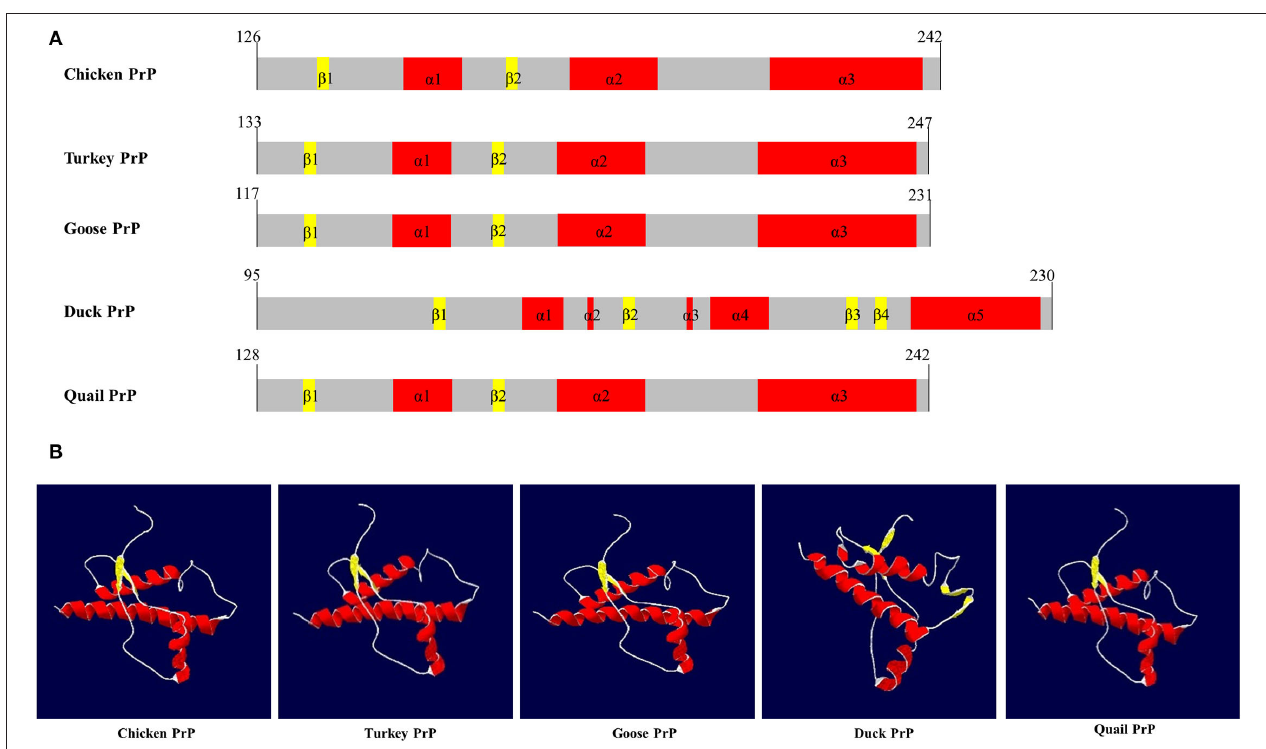
FIGURE 4 | The secondary and tertiary structures of avian PrPs. (A) The secondary structure of the avian PrPs. (B) The tertiary structure of the avian PrPs. The colors indicate α -helices (red), β -sheets (yellow), and coils (white).